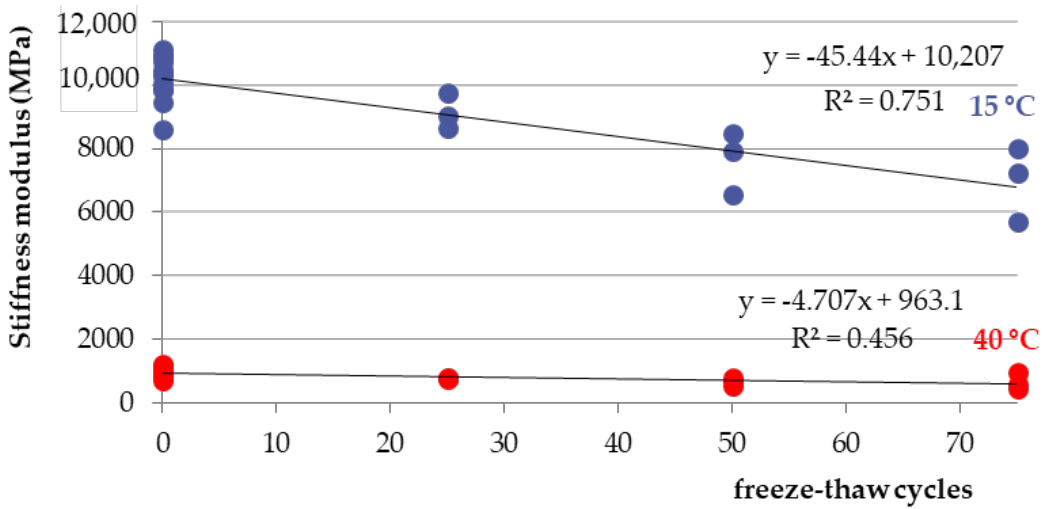
Figure 12. Stiffness of asphalt (MPa) depending on the number of freeze – thaw cycles.